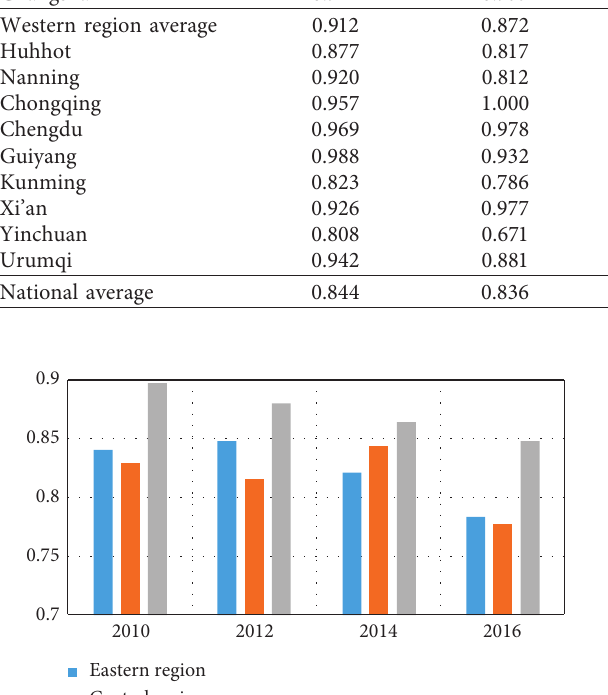
Figure 2: China’s average operation efficiency of bus